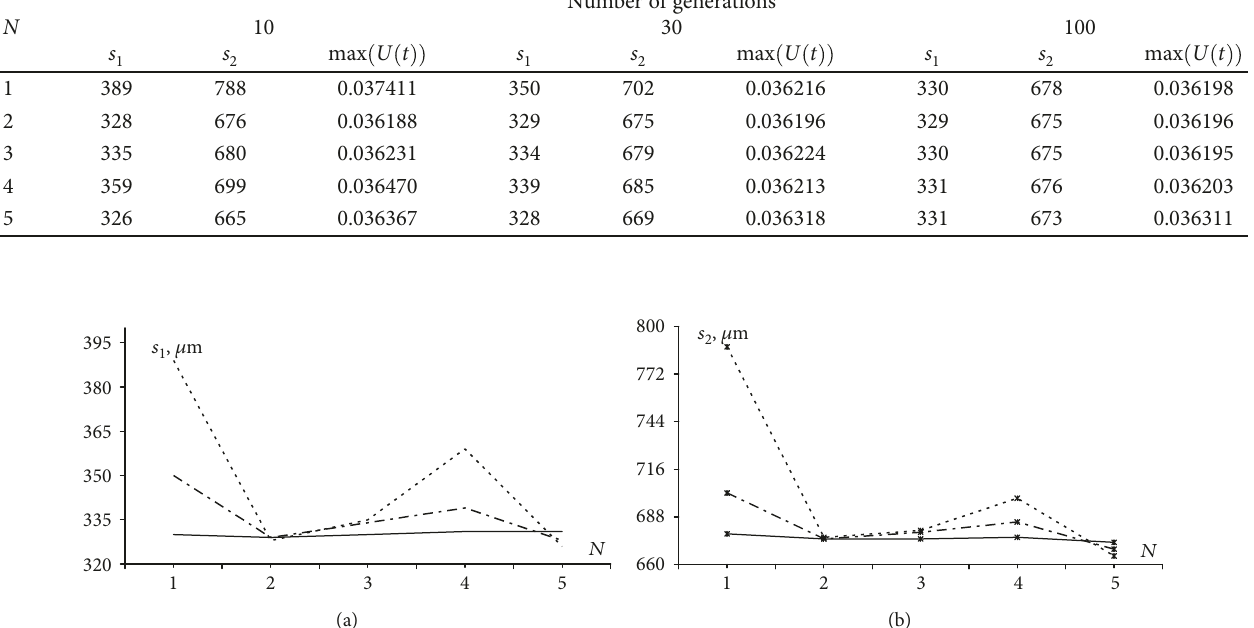
Figure 8: The results of GA optimization of s